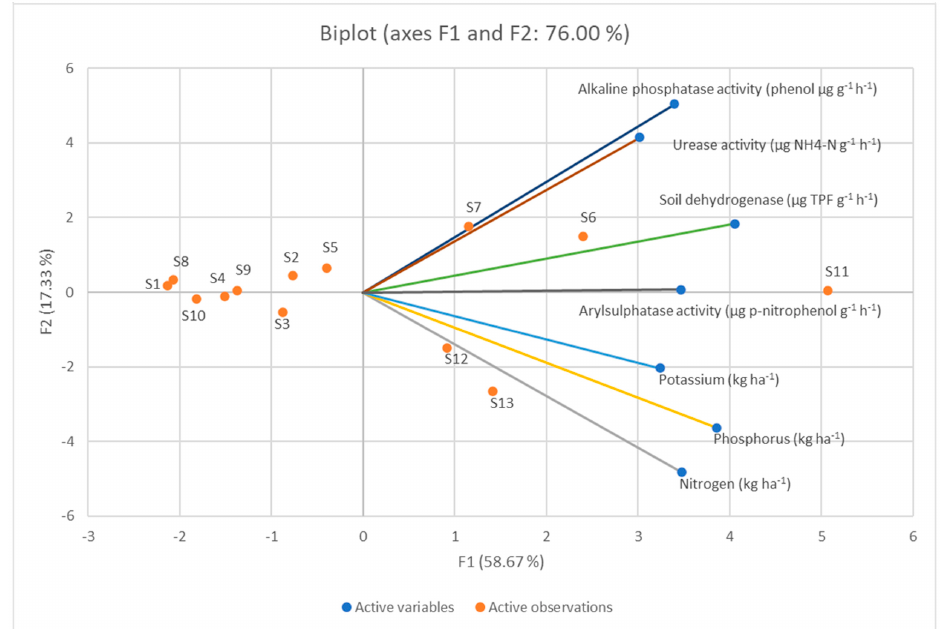
Figure 2. Principal Component Analysis (PCA) biplot representing different environmental factors of the soil of different rice planting systems. Active observations represent soil samples from 13 different locations. S1–S13 represents the thirteen soil samples collected from different locations.